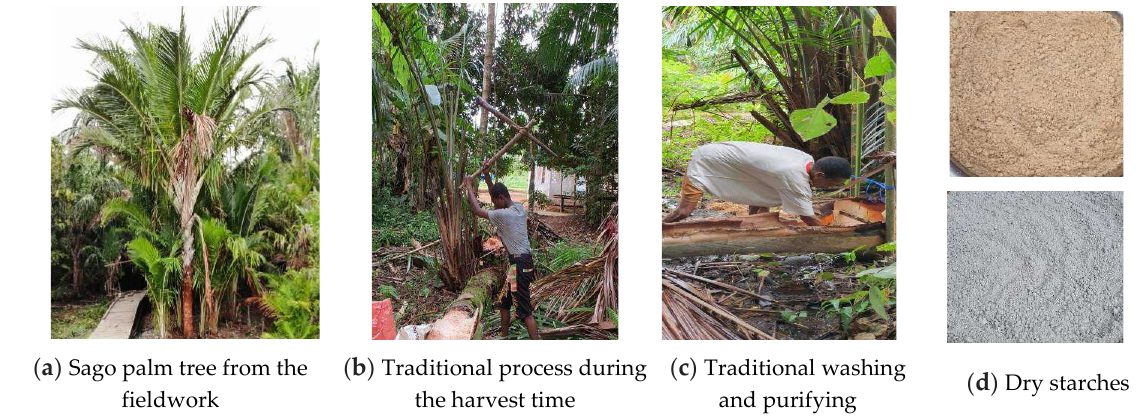
Figure 1. ( a ) Sago palm tree in the fieldwork. ( b ) Traditional bark removal and pulping. ( c ) Washing, purifying, and sieving to get the starch. ( d ) Dried sago starches are ready to use.